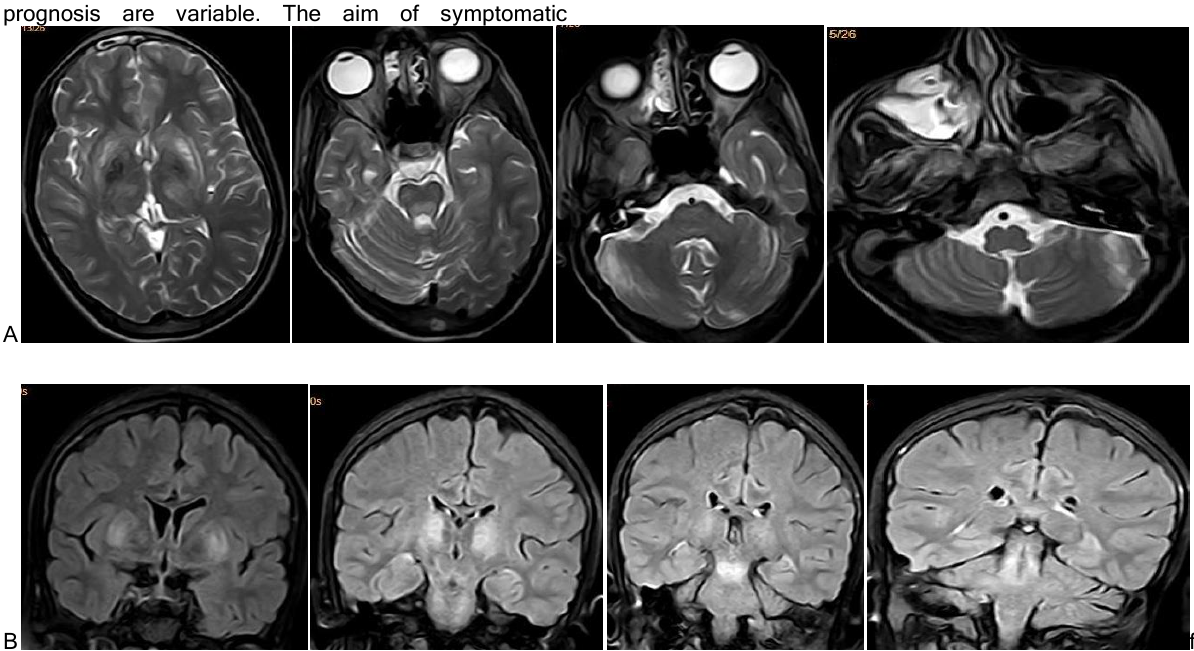
igure 1: (A)Serial axial non-contrast T2 MR Images and (B): Serial coronal FLAIR images show abnormal bilateral symmetrical hyperintense signals involving the basal ganglia (mainly the putamen), thalamus, cerebellar peduncles, mid brain, pons, medulla and the